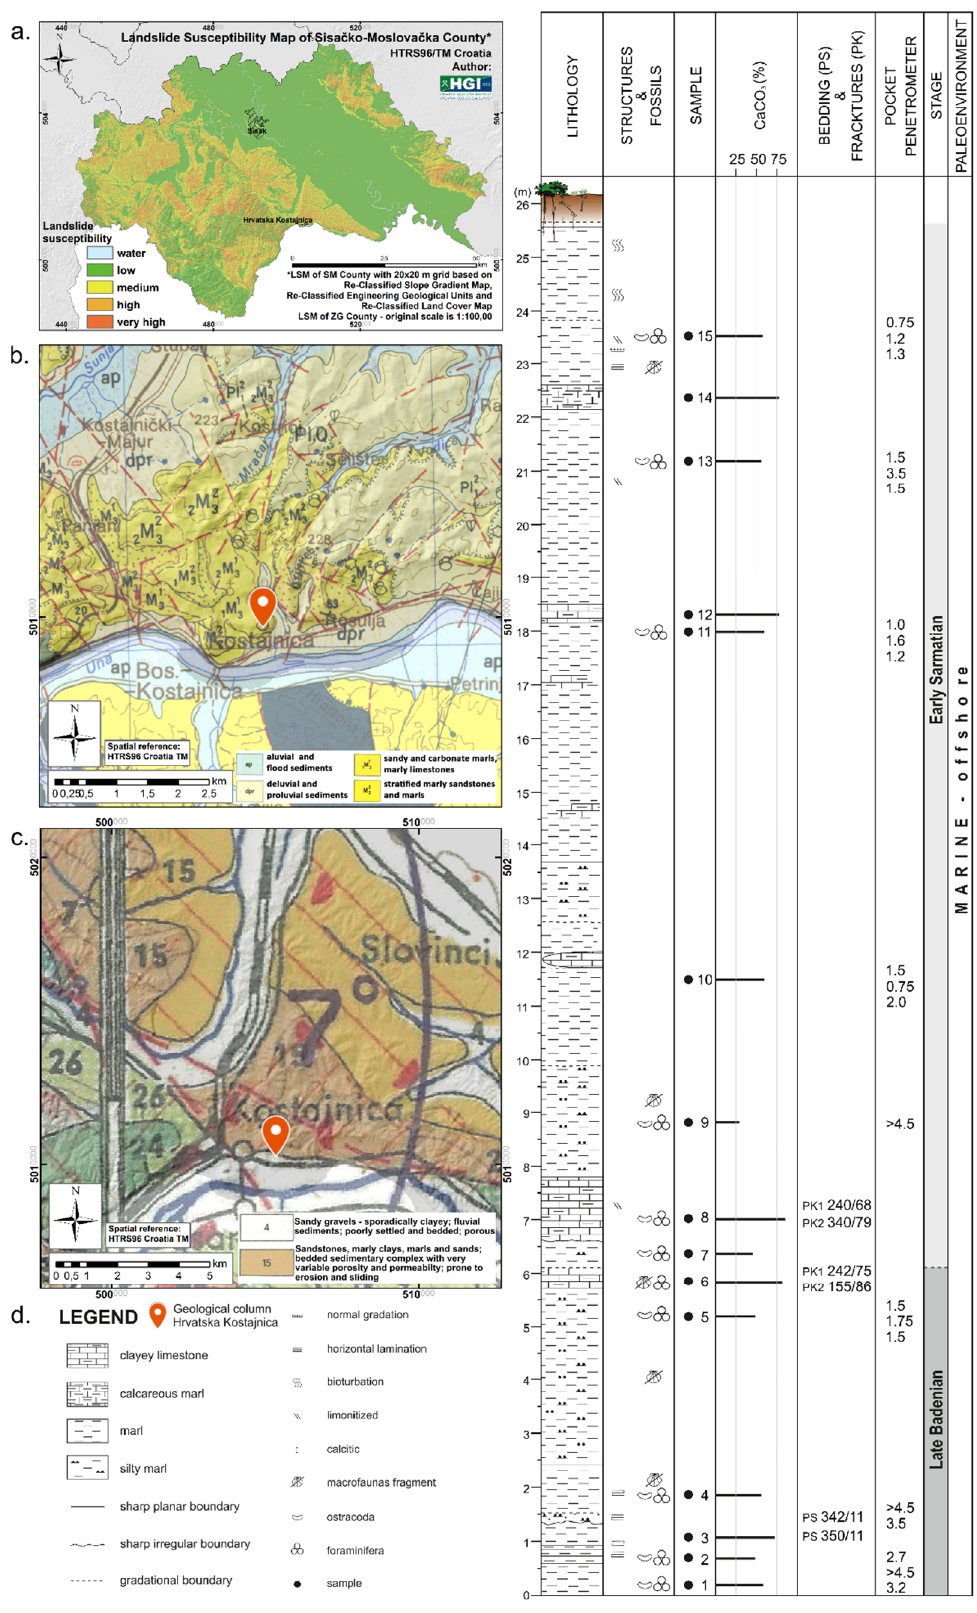
Figure 4. Study area “zoom in”: ( a ) landslide susceptibility Map of Sisa č ko-Moslavina County [4]; ( b ) detail from the Basic geological map [23]; ( c ) detail from the Engineering Geological Map [28]; and ( d ) the developed detailed geological column for Hrvatska Kostajnica landslide, modified after [24].